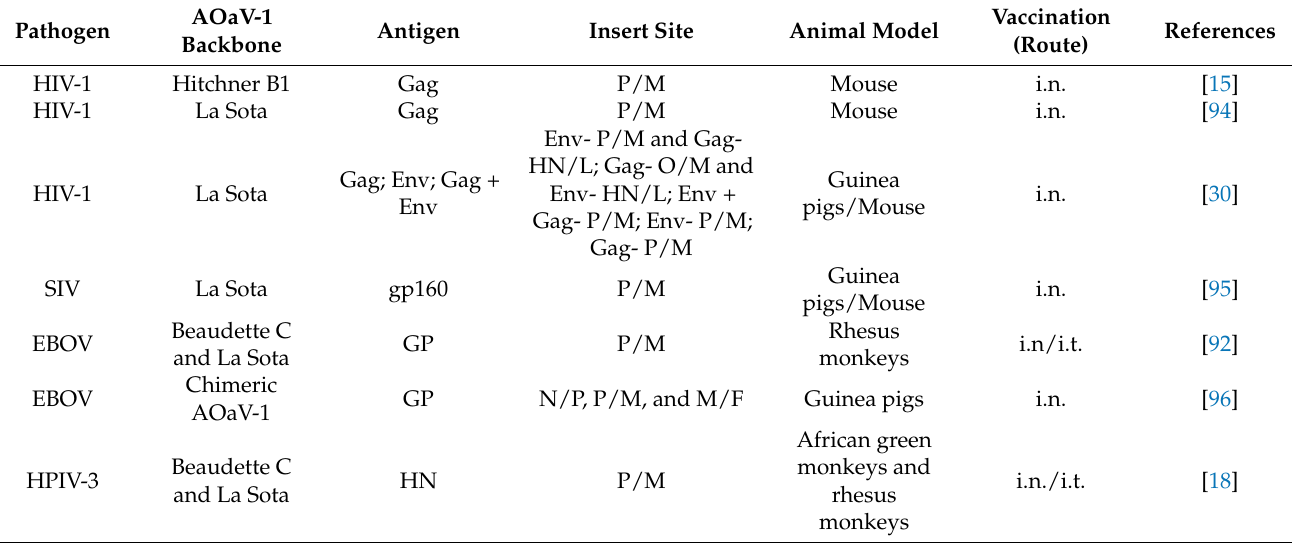
Table 3. Candidate AOaV-1-vectored vaccines for human